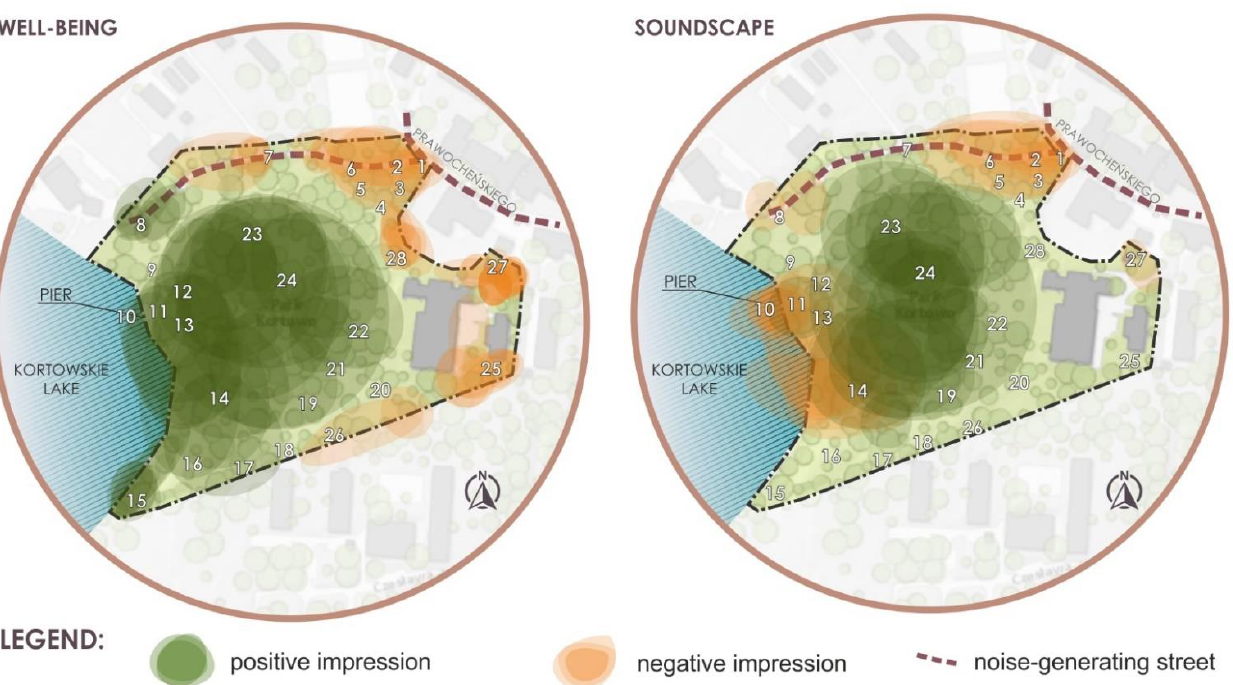
Figure 6. Mental maps of the Kortowo Park with positive and negative impression by park users in terms of well-being and soundscape perception.